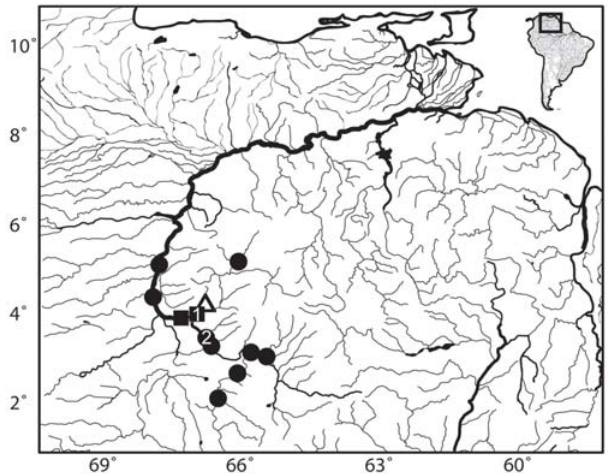
Fig. 3. Localities of Baryancistrus demantoides (triangle), Hemiancistrus subviridis (dots), and both species